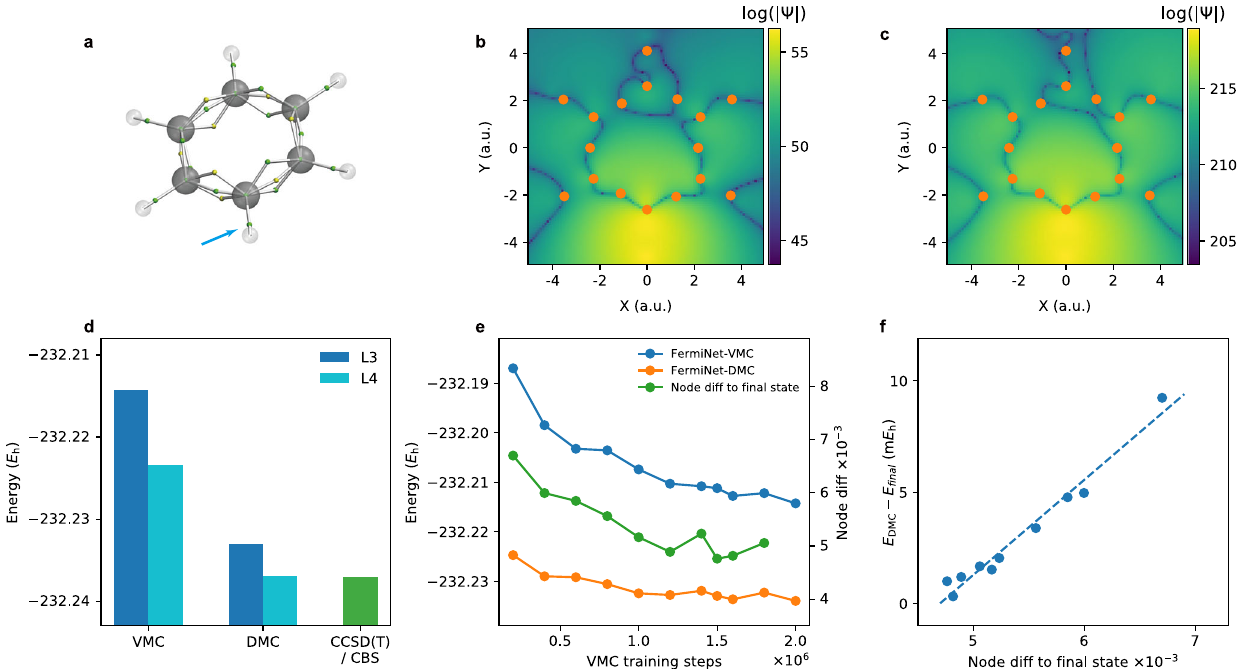
Fig.4 |Calculationsonbenzene.a Atomicstructureofthebenzenemoleculeand representative electron positions 39 . Small balls represent electrons, with spin indicatedbytheircolors,andlargerballsrepresentnuclei.Theelectronpointedby the blue arrow is an arbitrarily chosen one for nodal set visualization in b and c . Rods are drawn to connect the nucleus with electrons nearby. b and c The log- scaled magnitude of unnormalized FermiNet wavefunctions for a benzene mole- cule. Each slice is generated by moving a single spin-up electron in the square [ − 5a.u.,5a.u.] 2 on X – Y plane while fi xing all other electrons in the representative positions shown in a . The dark curves are the nodes and the orange points are the fi xed spin-up electrons projected onto X – Y plane. The moving electron for b and